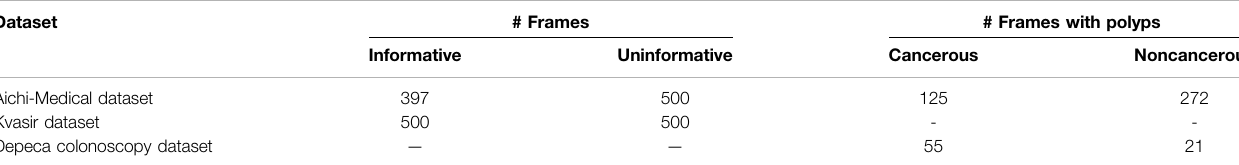
TABLE 1 | Summary of datasets used in this